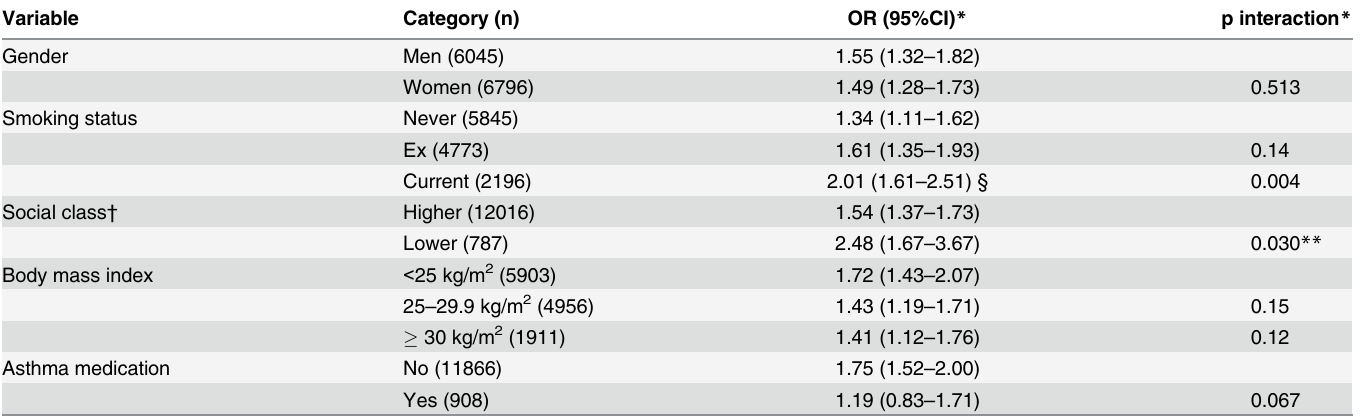
* OR from logistic regressions with adjustment for age, gender, smoking status, educational level and study centre (except the variable strati fi ed for). P- value for interaction term from similar model. †